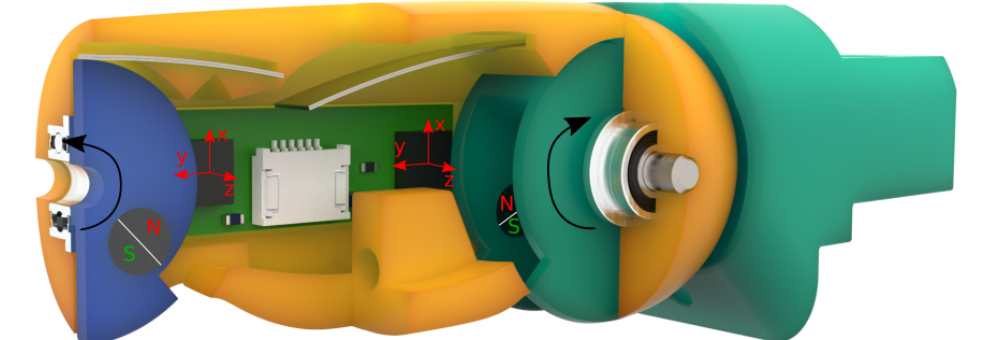
Figure 8. Section view of the little finger, with the distal/intermediate phalanx in blue, the proximal phalanx in orange and the knuckle in green, showing the joint angle encoders and magnets used to determine the joint rotational angles.